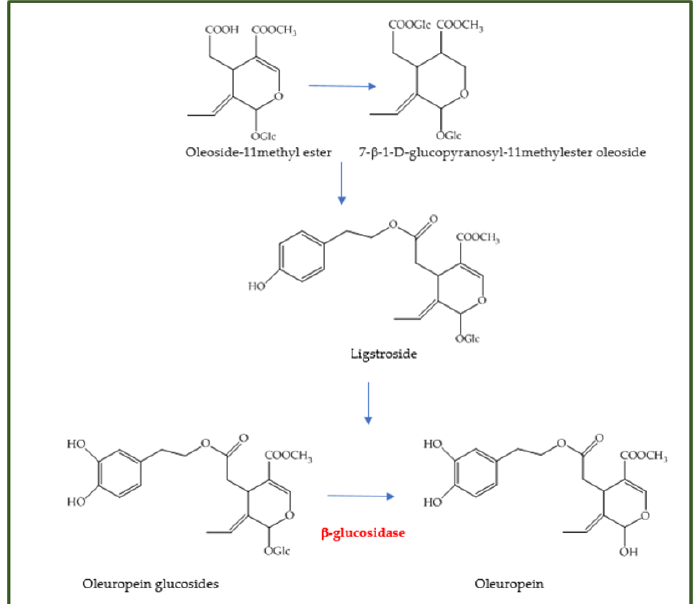
Appl. Sci. 2021 , 11 , x FOR PEER REVIEW Figure 5. Oleuropein biosynthesis. Figure 5. Oleuropein biosynthesis. About flavonoids, an improvement of the flavone luteolin’s level (except in olive drupes obtained from plants treated by T22) and a decrease in the flavonol rutin’s concentration (except in olive drupes obtained from plants treated by 6PP) were observed in all tested samples (Table 4), indicating the ability of the treatments (except T22 and 6PP) to affect principally the flavone synthase activity rather than flavonol synthase (Figure 6).